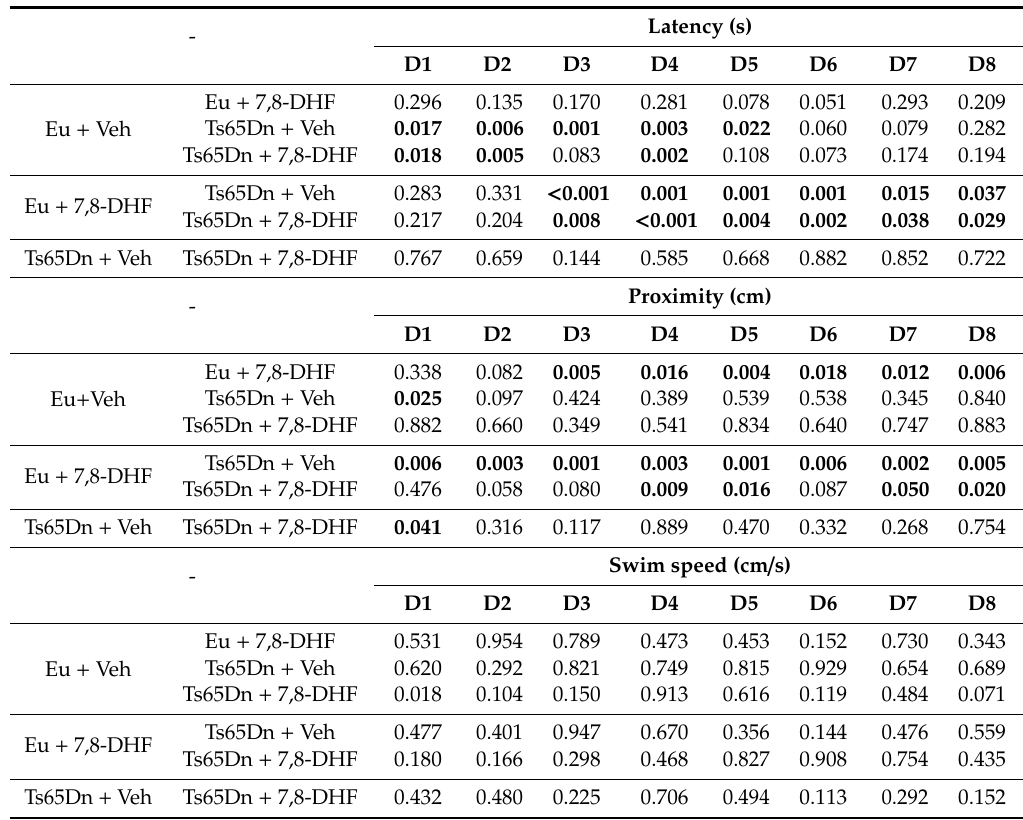
Table 2. p values of the Fisher LSD test for the indicated variables, during the learning phase of the MWM in euploid and Ts65Dn mice treated with vehicle or 7,8-DHF for 40 days, starting from 4 months of